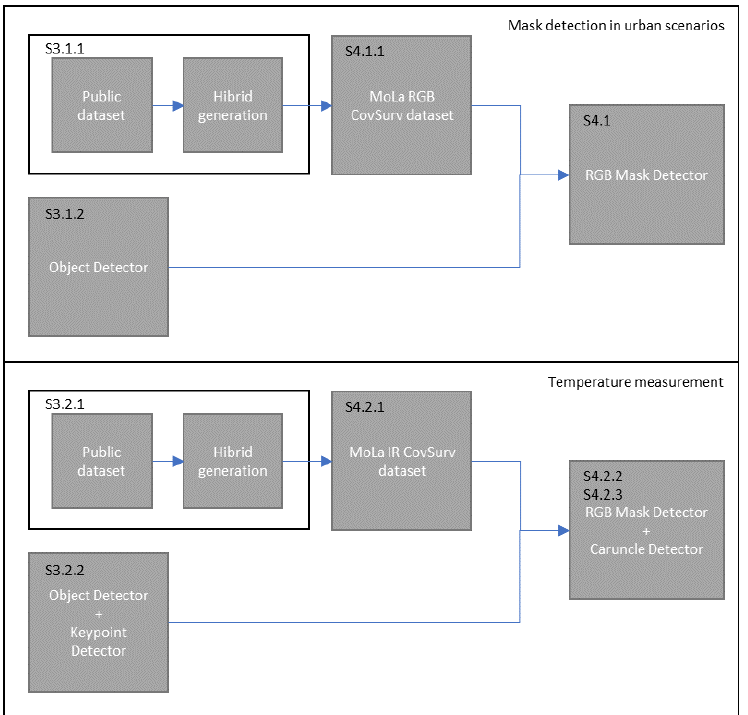
Figure 2. Two development pipelines are presented: (1) mask detection in urban surveillance; (2) temperature measurement. For each pipeline, 3 identical steps are made: (1) a toolchain for data generation is implemented (S3.1.1 and S3.2.1); (2) models are selected (S3.1.2 and S3.2.2); (3) datasets are generated (S4.1.1 and S4.2.1) to evaluate each model (S4.1, S4.2.2, and